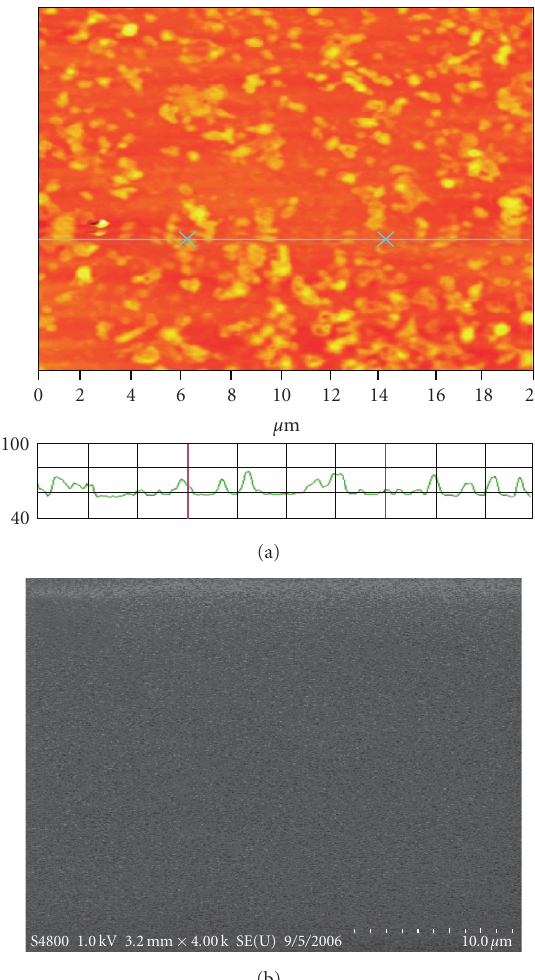
Figure 8: (a) AFM and (b) SEM images of a 12 PDMS-1/PDMS-2 bilayered film prepared from a 0.025 M bu ff er solutions. Z scale was in